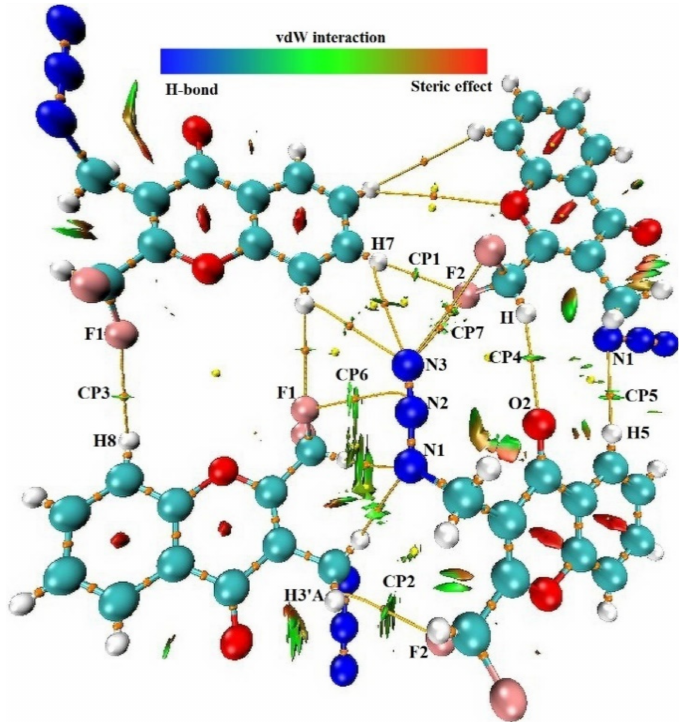
Figure 5. Combined AIM/NCI plot analysis of 4 ’s tetramer. The bond’s critical points (CPs) are represented as yellow spheres with CP labels. For NCI plot, the RDG isosurface is 0.5 and the color range is −